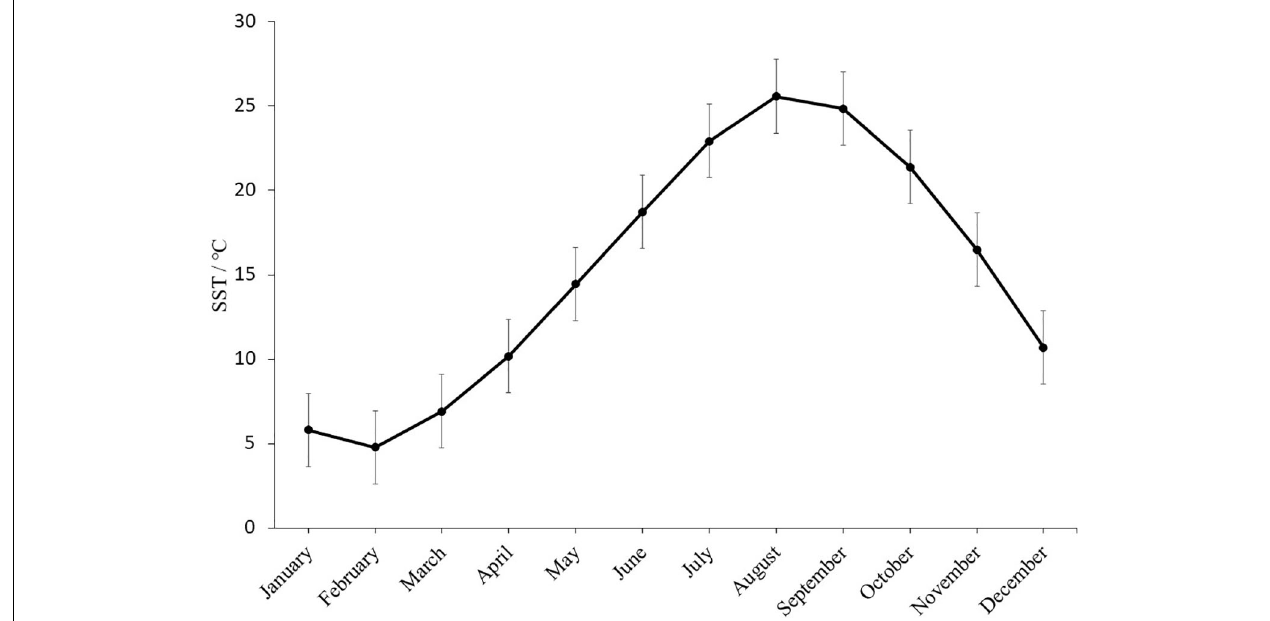
FIGURE 2 | Average monthly of sea surface temperature (SST) of the Qingdao in 2019.